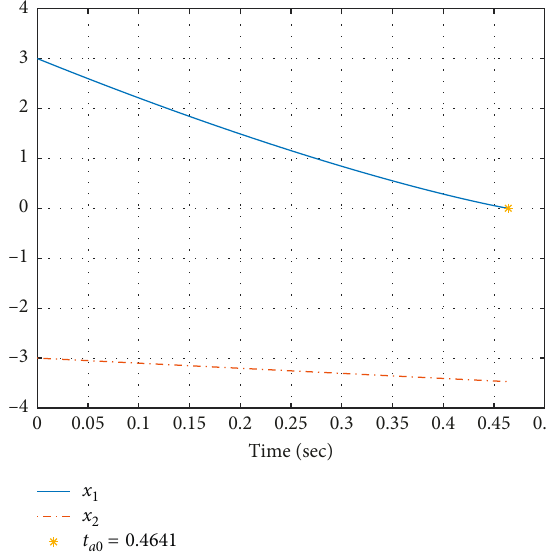
Figure 7: Finite-time convergence to the origin point with the nonzero initial condition of the state ( A � ( − 2/9)).